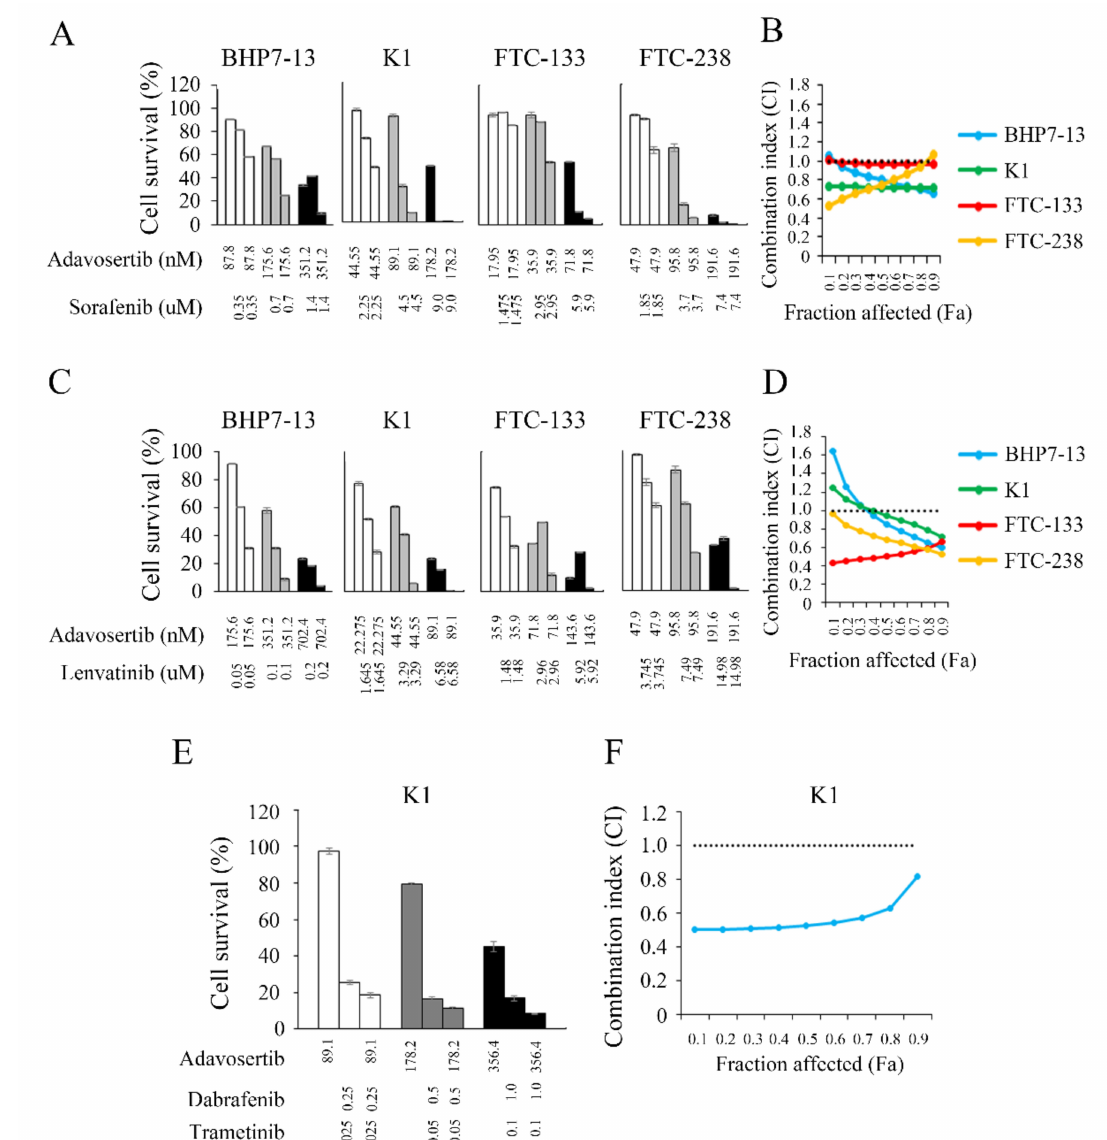
Figure 5. Adavosertib synergistically enhances the cytotoxic effects of sorafenib, lenvatinib, and dabrafenib plus trametinib in DTC cells. ( A ) The cytotoxic effects of adavosertib and sorafenib alone or in combination after a 4-day treatment in BHP7-13, K1, FTC-133, and FTC-238 cells were evaluated using lactate dehydrogenase assays. ( B ) CompuSyn software evaluated the combination index (CI) of adavosertib and sorafenib. The combination of adavosertib and sorafenib had synergistic effects in the K1 cells and synergistic to antagonistic effects in the BHP7-13, FTC-133, and FTC-238 cells. The combination of adavosertib and sorafenib presented synergistic effects in BHP7-13 and FTC-133 when the fraction affected was ≥ 0.2 and in FTC-238 when the fraction affected was <0.9. ( C ) We employed lactate dehydrogenase assays to determine the cytotoxicity of adavosertib, lenvatinib, and the combination of adavosertib and lenvatinib for a 4-day treatment in the BHP7-13, K1, FTC-133, and FTC-238 cells. ( D ) CompuSyn software assessed the CI of adavosertib and lenvatinib in the four DTC cell lines. Adavosertib plus lenvatinib was synergistic in FTC-133 and FTC-238 and synergistic to antagonistic in BHP7-13 and K1. ( E ) We assessed the cytotoxicity of adavosertib, dabrafenib plus trametinib, and triple combination of adavosertib, dabrafenib, and trametinib for a 4-day treatment in the K1 cells. ( F ) CompuSyn software calculated the CI of adavosertib and dabrafenib plus trametinib. The combination of adavosertib and dabrafenib plus trametinib demonstrated synergistic effects (CI, 0.50–0.82) in the K1 cells. The horizontal dotted line at CI = 1 was drawn to discriminate synergism (CI < 1) from antagonism (CI >